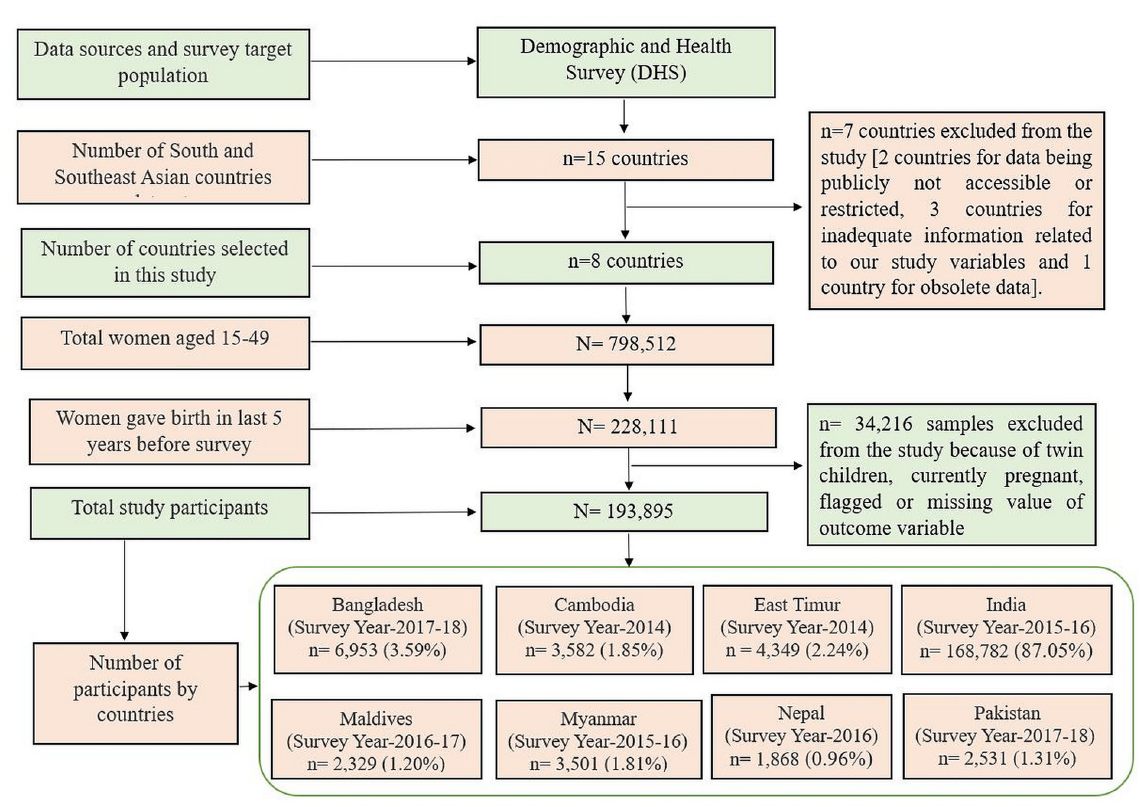
Fig 1. Distribution of the study participants and year of the survey across eight